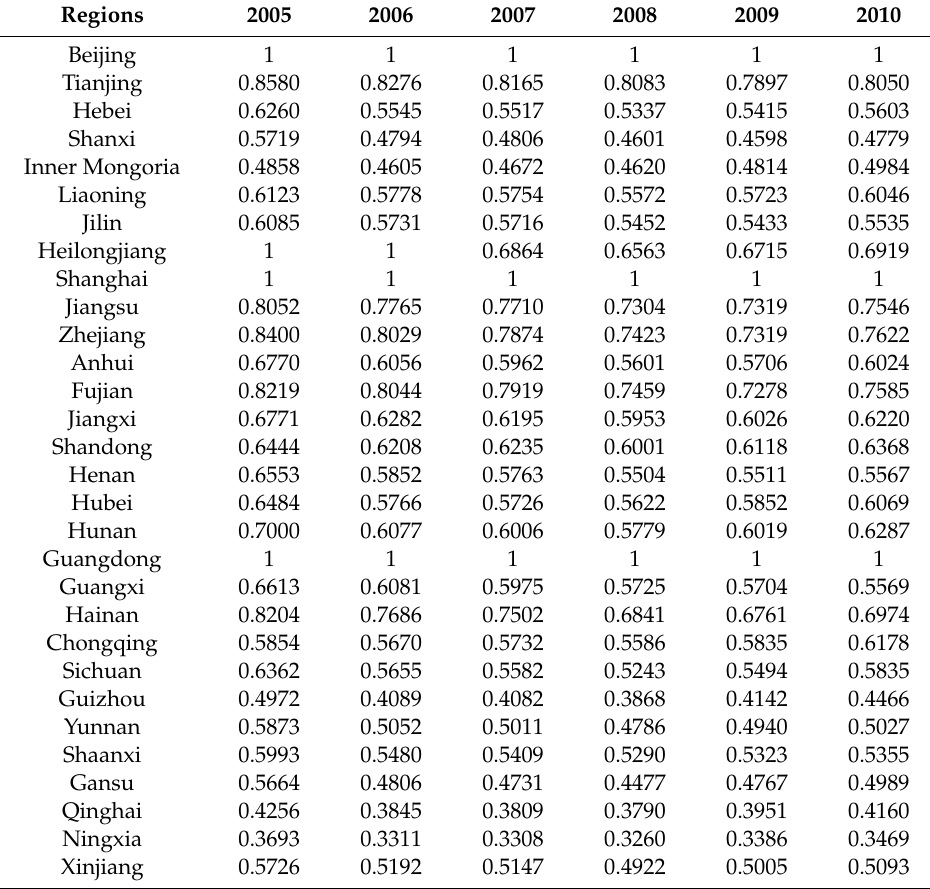
Table 3. Carbon emission e ffi ciency of 30 provinces in China from 2005 to